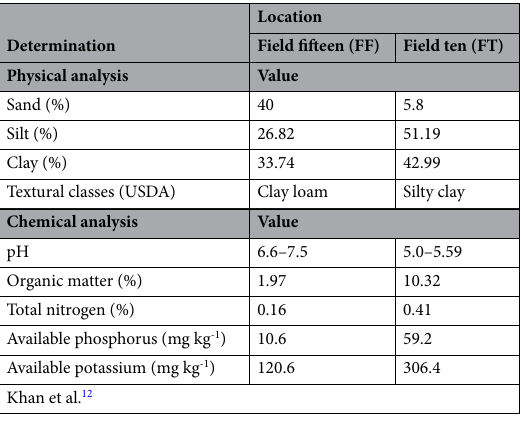
Table 3. Characterization of soil properties of the experimental